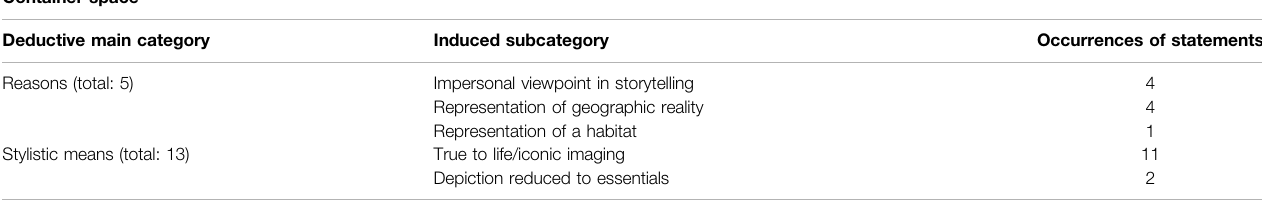
TABLE1| Theparticipants ’ reasoningandplanneduseofstylisticmeansfortheconceptofspaceoftheirchoice.Thetableisorganizedaccordingtotheconceptsofspace, listing the participants ’ reasons and stylistic ideas based on the transcripts in each section. Container